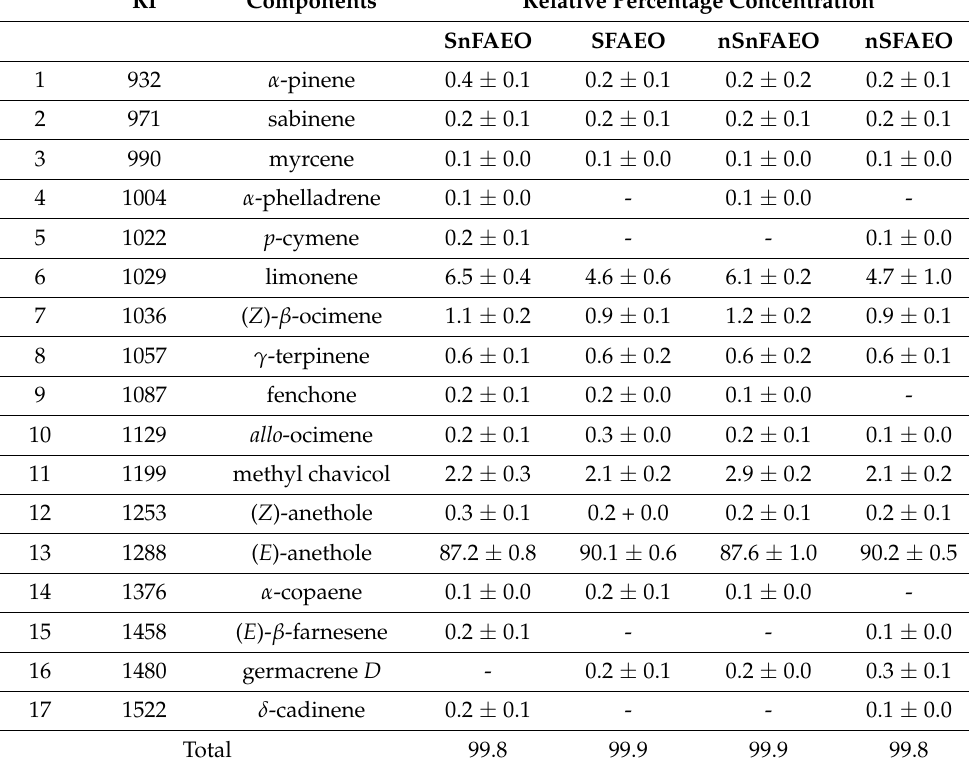
Table A2. Anise’s essential oils chemical composition under different treatments. % (mean ± SD). SnFAEO: Shade without Fertilizer Anise Essential Oil, SFAEO: Shade with Fertilizer Anise Essential Oil, nSnFAEO: without Shade without Fertilizer Anise Essential Oil, nSFAEO: without Shade with Fertilizer Anise Essential Oil. Components are listed in order of elution from an TG-5MS column. Retention indices (RI), relative to n -alkanes, are listed alongside published values (Pub. RI from Adams 2007). Mean ± SD ( n =